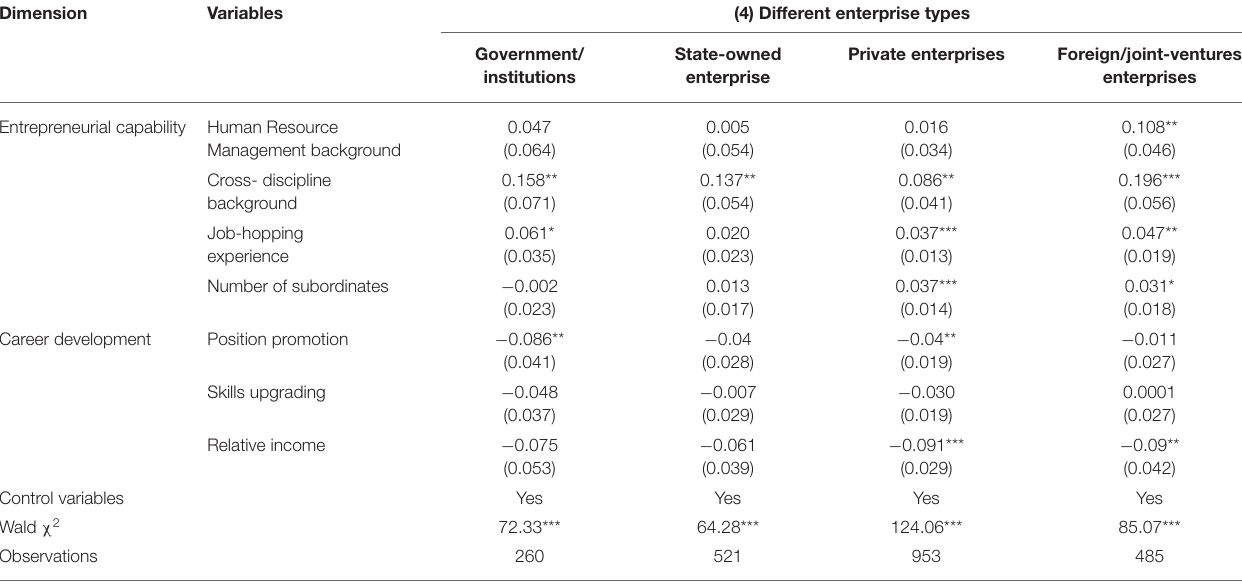
TABLE 4 | Heterogeneous analysis results in different enterprise types. Dimension